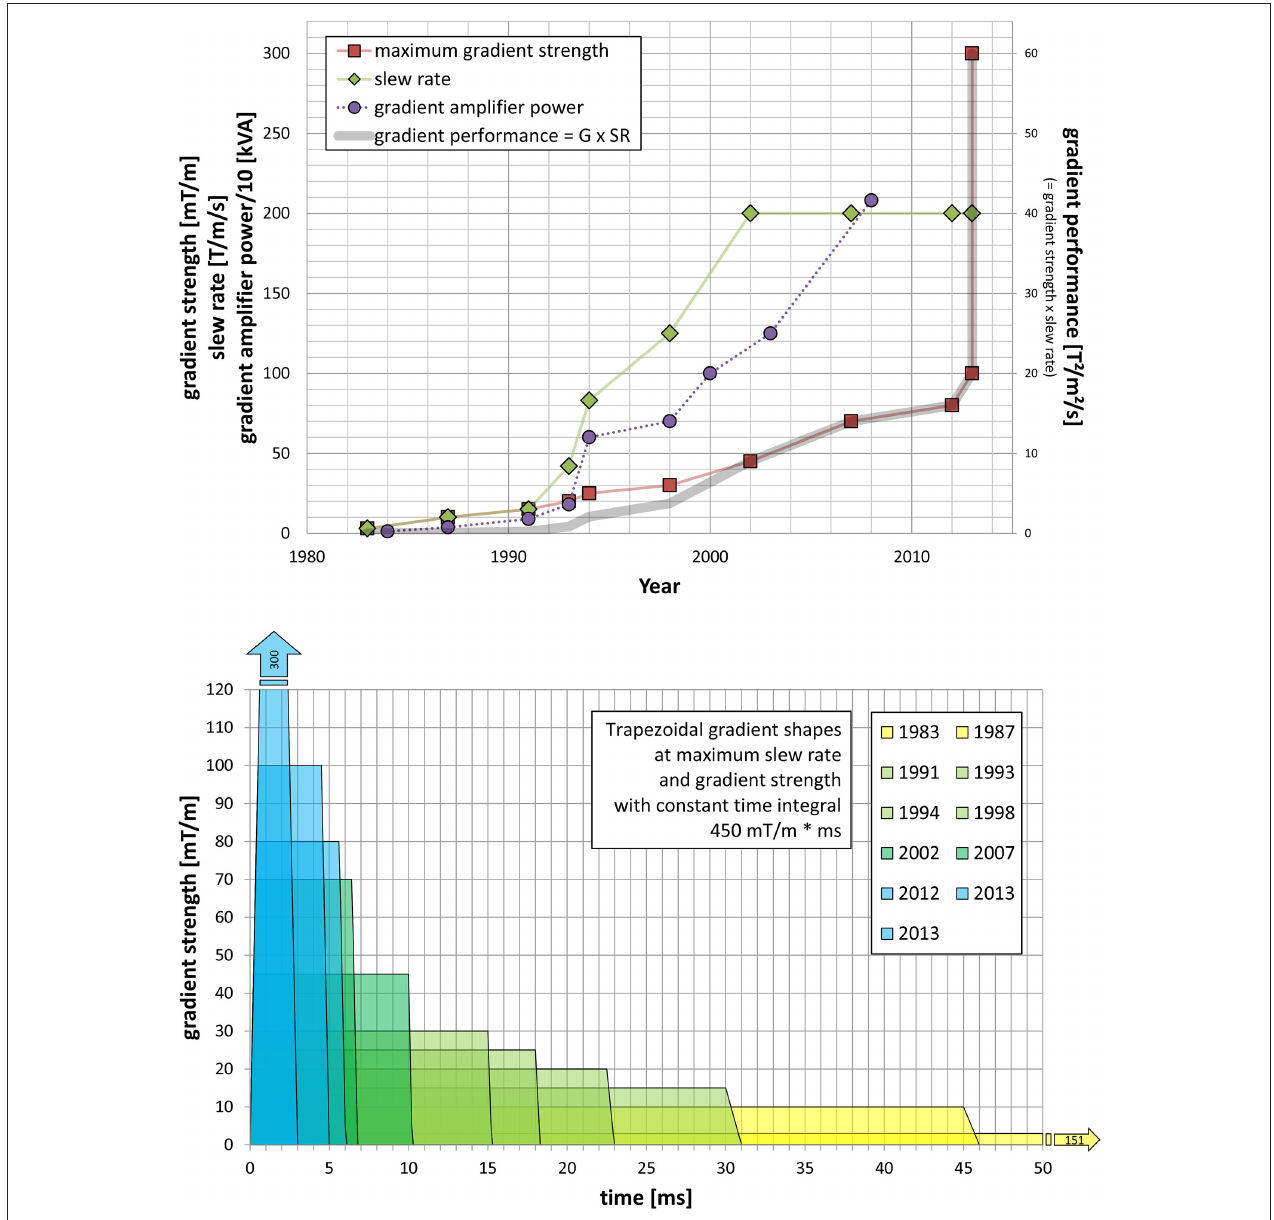
FIGURE 4 | (A) Shows the development of gradient coils for human MRS and MRI research and clinical diagnostics in terms of maximum gradient strength (mT/m, red) and slew rate (T/m/s, green), as well as gradient amplifier power development (left y-axis, purple). The product of maximum gradient strength and slew rate is the gradient performance (right y-axis, thick gray line). (B) Development of trapezoidal gradient shapes at maximum slew rate and gradient strength with constant time integral of 450 mT/m*ms, plus equivalent triangular gradient shape, i.e., without plateau time at the maximum gradient strength, for the strongest gradient available at a certain